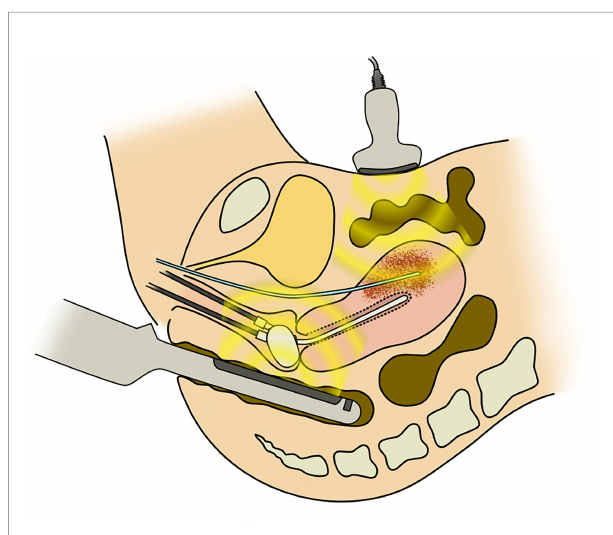
FIGURE 1 | The schema of transabdominal and transrectal ultrasonography- guided interstitial needle